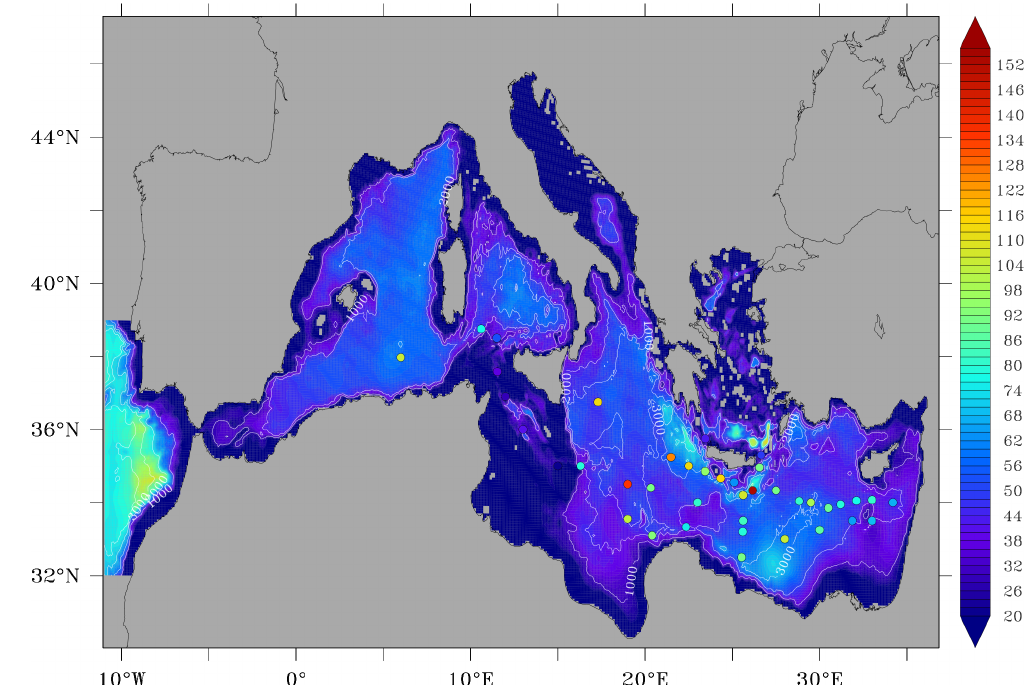
Figure 9. Inventory of δC T (molm − 2 ) in November 2001 from the MED simulation (color-filled contours) and from Schneider et al. (2010) data-based estimates (color-filled dots). The Mediterranean bathymetry is shown as white isobaths every 1000m.